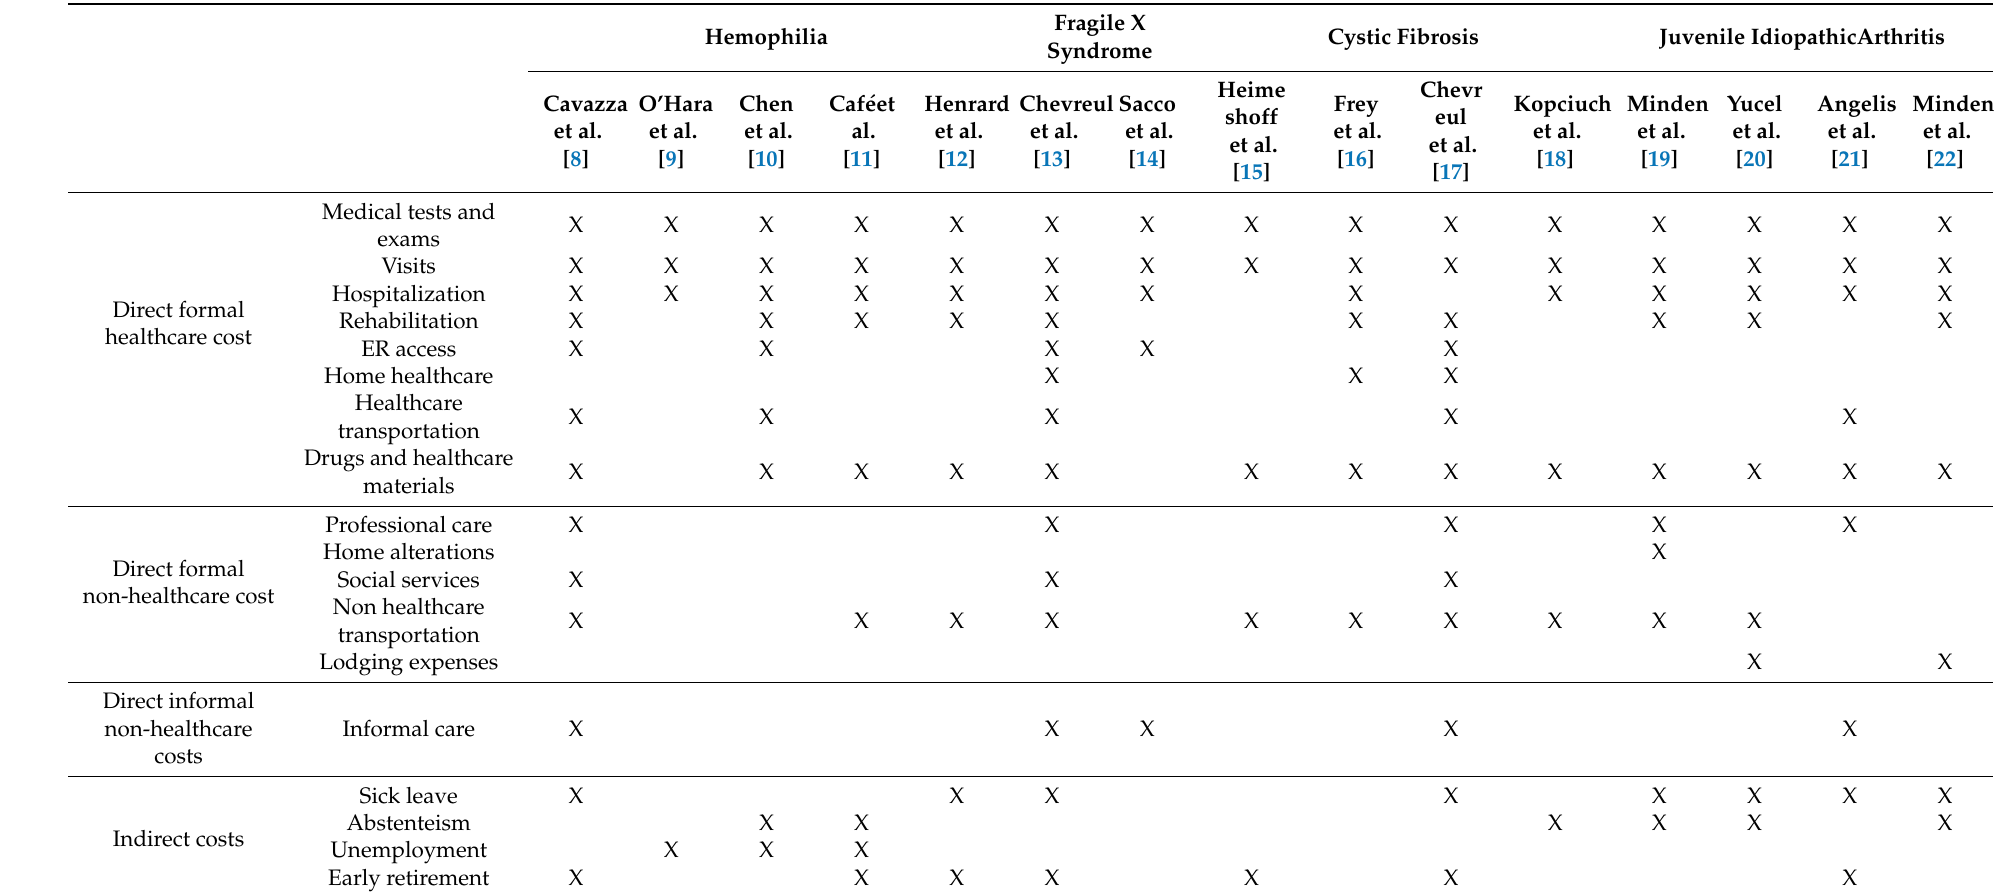
Table 2. Summary of cost items considered by the samples of cost of illness